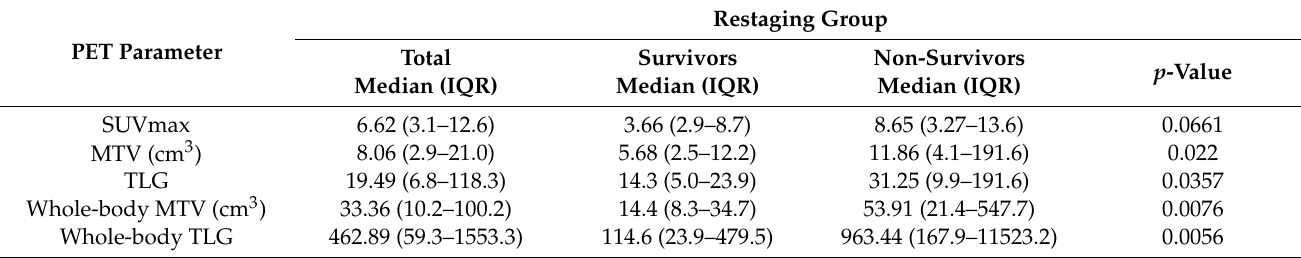
Table 2. Metabolic PET parameters of survivors and